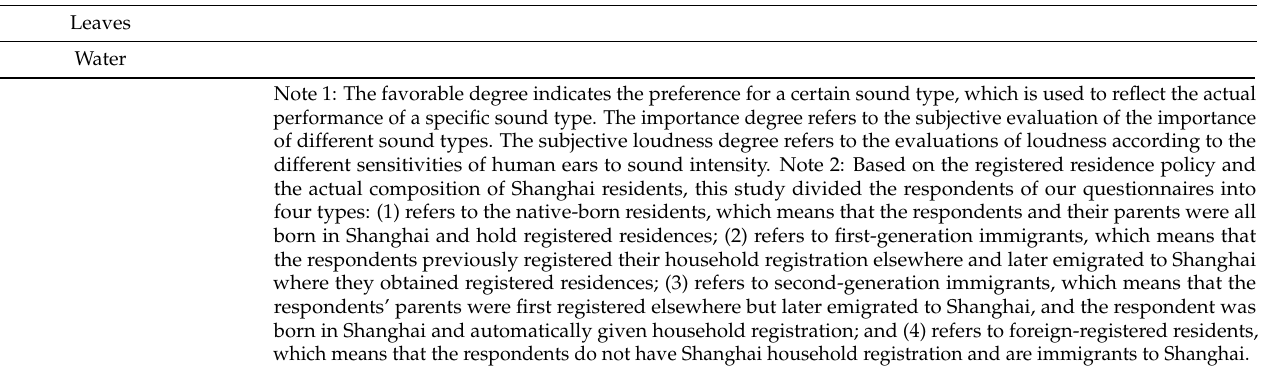
Table A3. Semantic Perception Evaluation of Soundscape